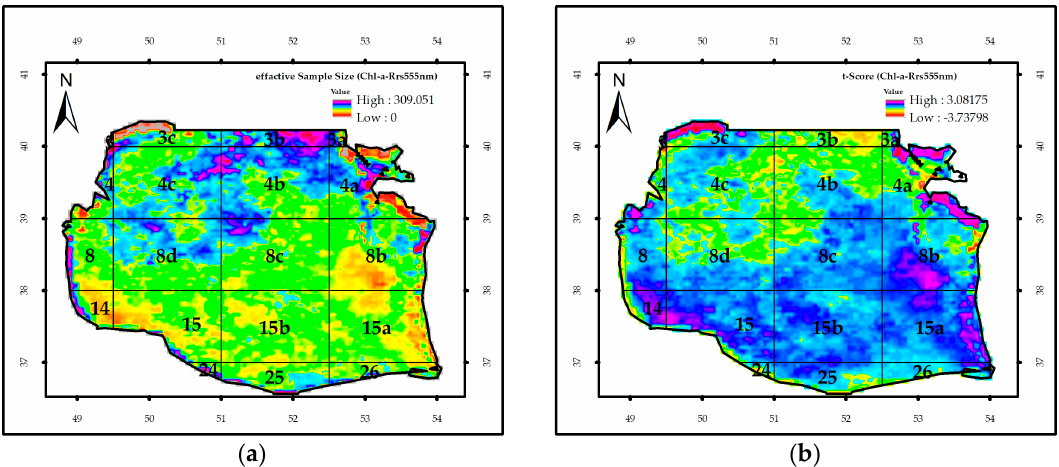
Figure 10. The image of the effective sample size (ne) ( a ) and the value of t for the regression of Chl-a and Rrs_555nm ( b ) in the SCS.